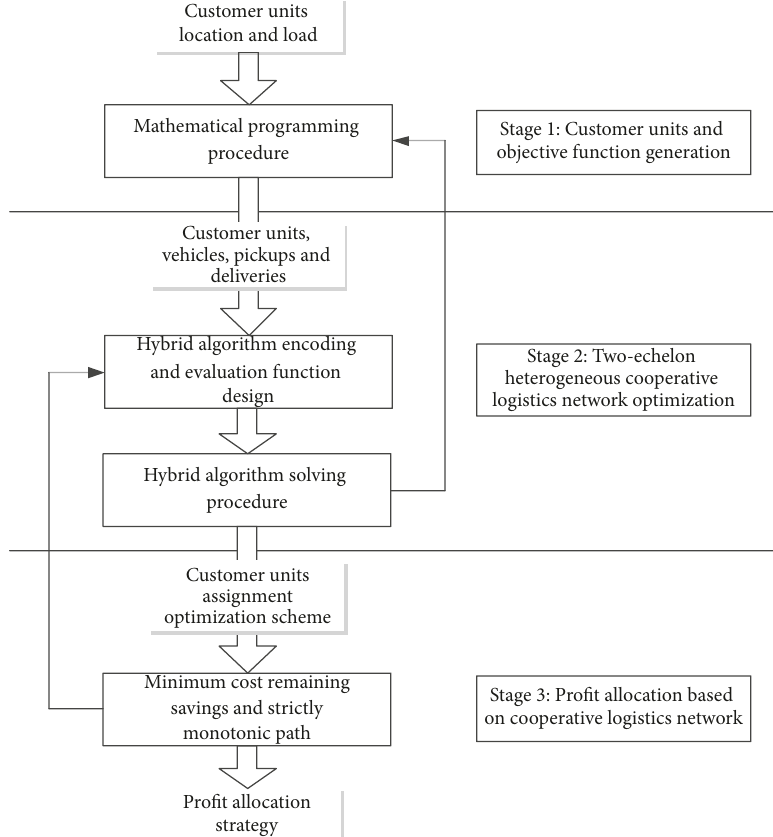
Figure 2: Logistics network optimization